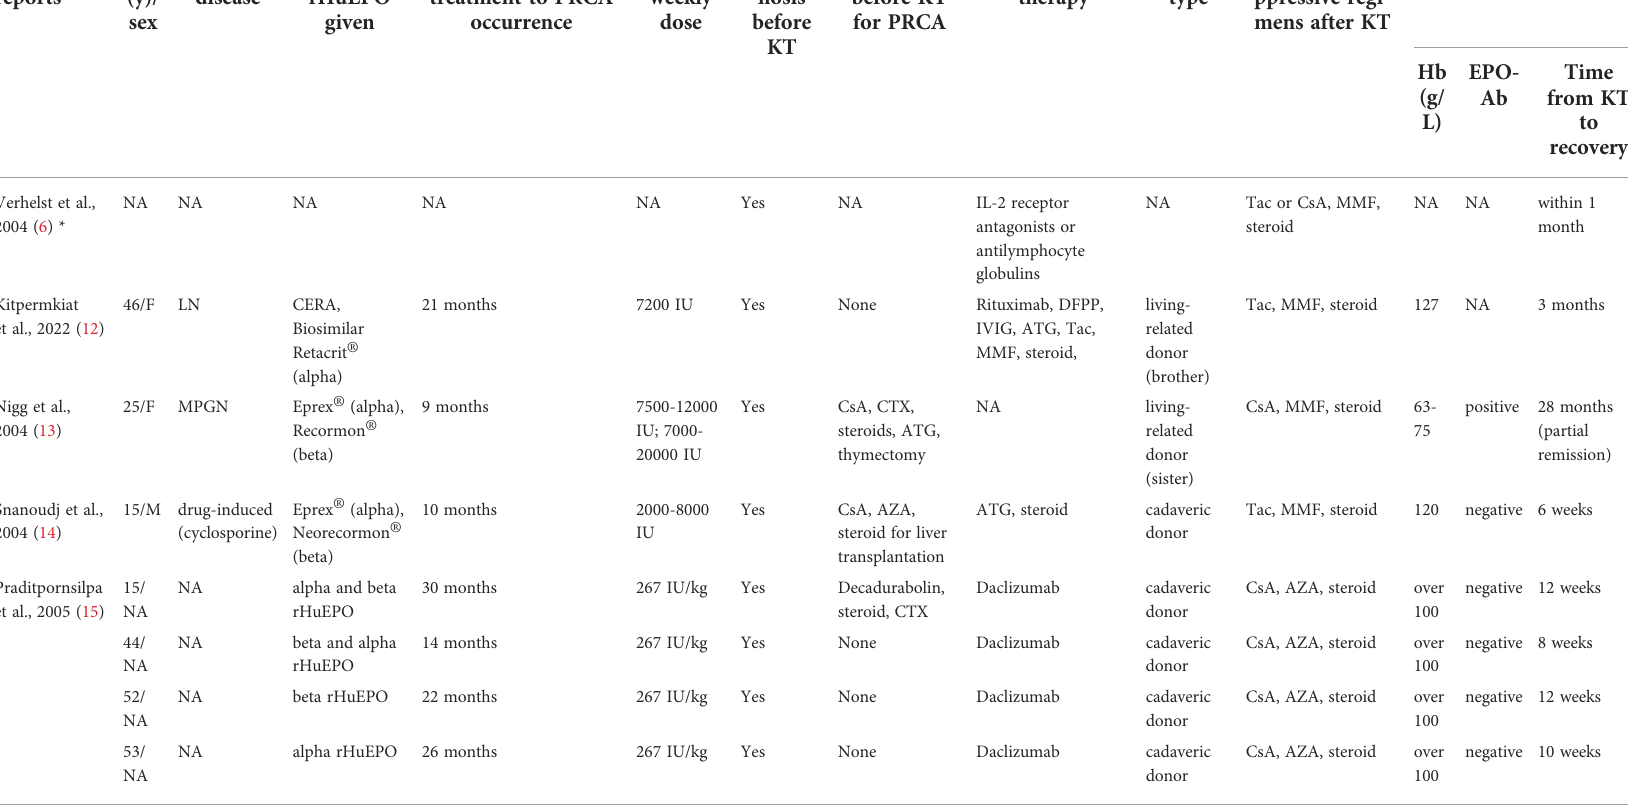
TABLE 1 Clinical characteristics of 13 reported cases of anti-rHuEPO antibody-mediated PRCA who underwent kidney transplantation. Case